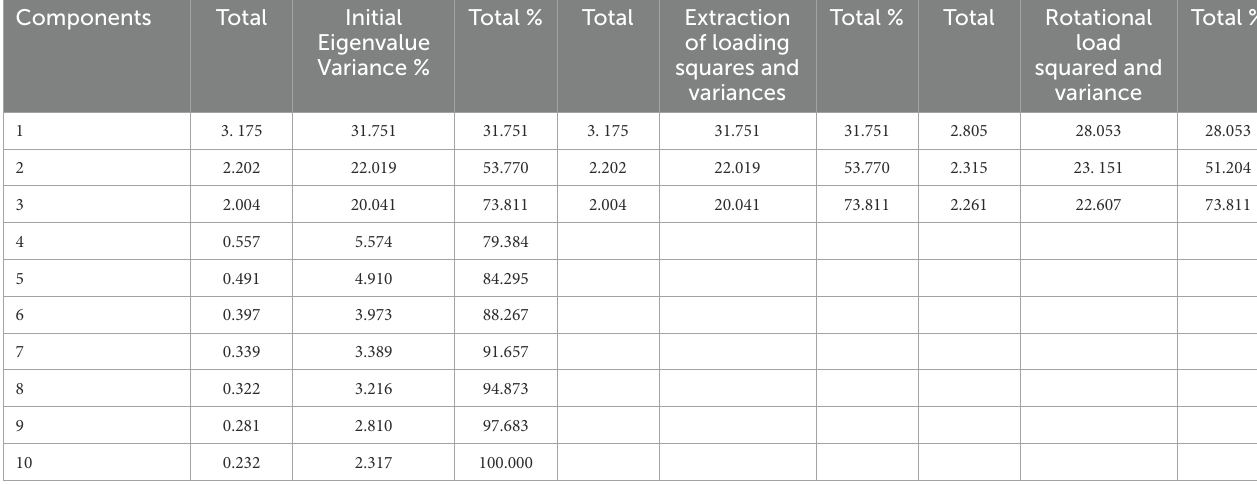
TABLE 9 Factor analysis of empirical scales.